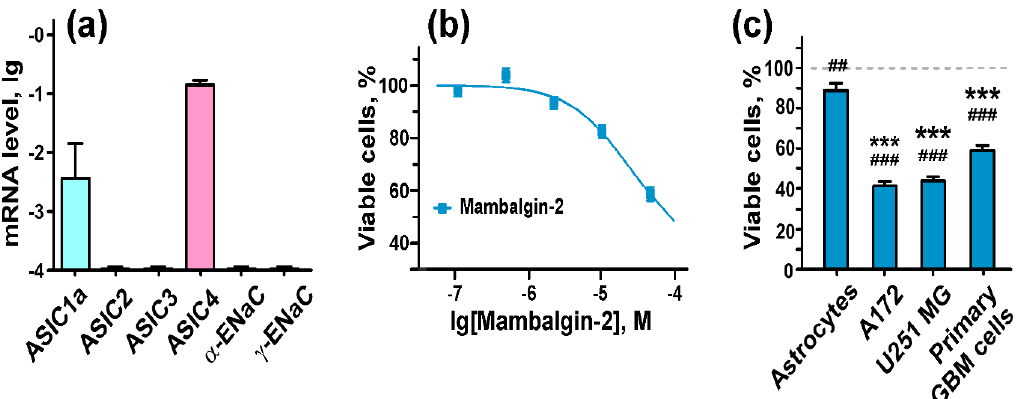
Figure 8. Mambalgin-2 effect on cells of primary culture obtained from a patient with glioblastoma (GBM). ( a ) Analysis of ASICs and ENaCs gene expression in primary GBM cells by qPCR. Gene expression was normalized to the β -ACTIN, GPDH and RPL13a housekeeping genes and presented as lg of relative mRNA level ± SEM ( n = 3–5); ( b ) Influence of different mambalgin-2 concentrations on viability of primary GBM cells. Cells were incubated for five days with mambalgin-2 and their viability was accessed by Alamar Blue assay. Data are presented as % of control (untreated cells) ± SEM (n = 3); ( c ) Comparison of the 50 µM mambalgin-2 inhibitory effect on viability of normal astrocytes, U251 MG, A172, and primary GBM cells by Alamar Blue assay. Data are presented as % of control (untreated cells, dashed line) ± SEM (n = 3). ## ( p < 0.01) and ### ( p < 0.001) indicate significant difference between treated and untreated cells according to One-way ANOVA followed by Dunnett’s test. *** ( p < 0.001) indicates significant difference of mambalgin-2 action on cells from the effect on astrocytes according to One-way ANOVA followed by Dunnett’s test.